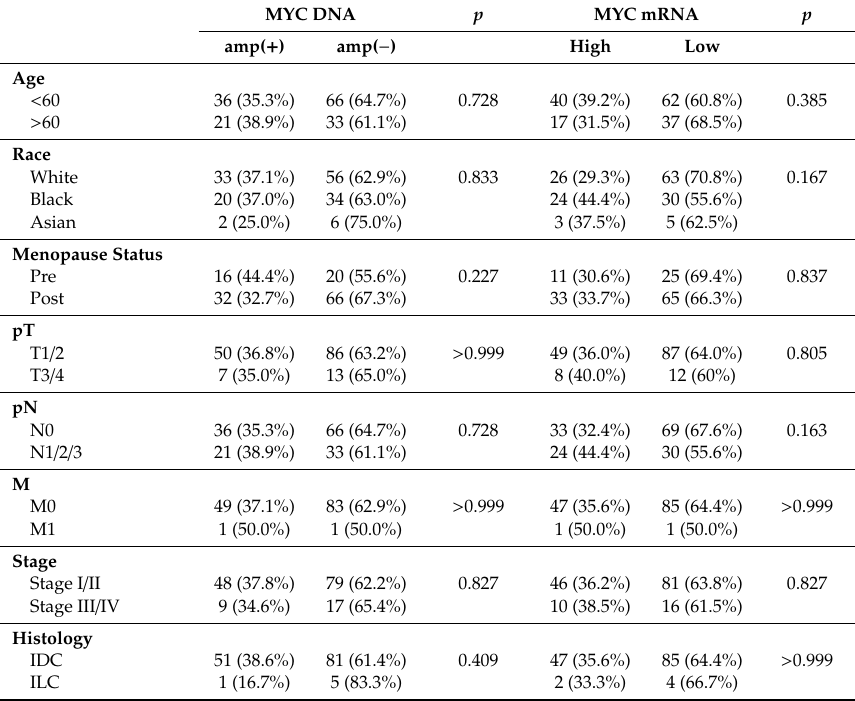
Figure 4. The impacts of the MYC DNA amplification and mRNA expression on patient survival in TCGA TNBC cohort. ( A ) The proportion of each group by MYC DNA amplification and mRNA expression in TNBC. ( B ) Overall survival comparing the MYC DNA non-amplified (DNA amp( − ) in black) and amplified (DNA amp( + ) in red) tumors in TNBC. ( C ) Overall survival comparing the MYC mRNA low (mRNA low in blue) and high (mRNA high in orange) expressing tumors in TNBC. Table 1. Clinical demographics by MYC DNA amplification and mRNA expression in TCGA Triple-Negative Breast Cancers